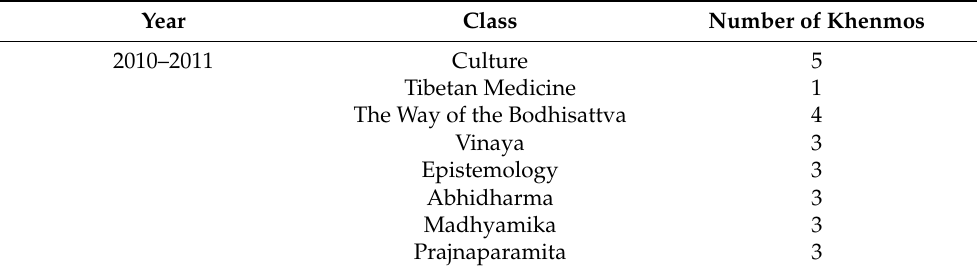
Table 3. The number of Khenmos and the curriculum from 2010 to